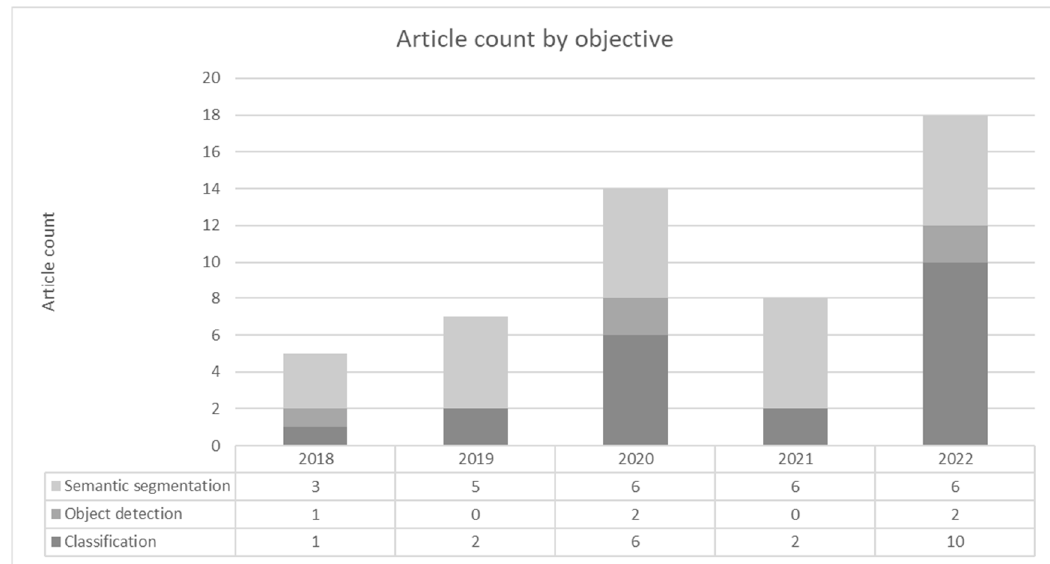
Figure 2. Distribution of search results by year and objective. Table 2. Model performance metrics